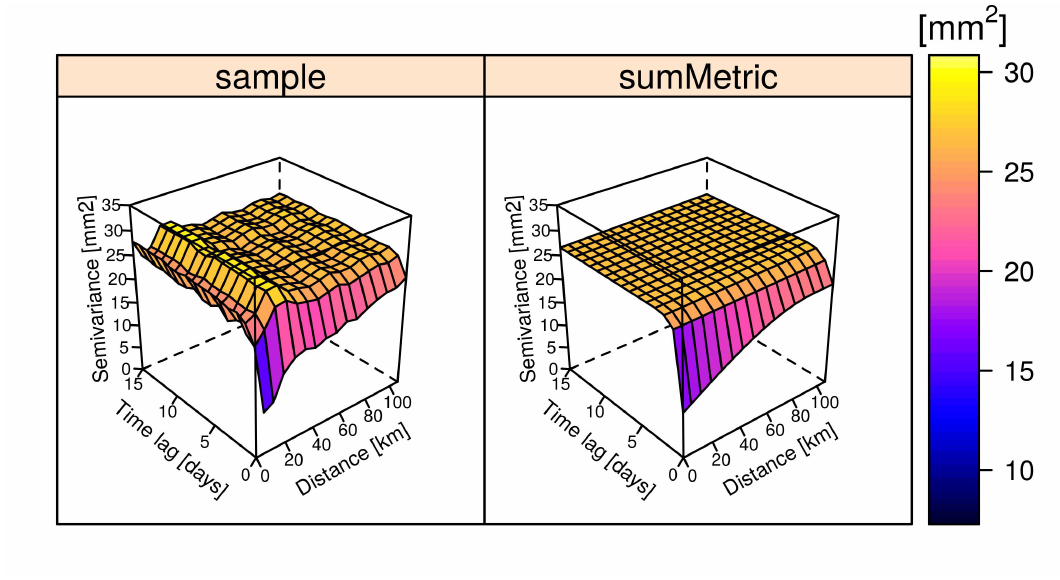
Figure 9. STRK sample semivariogram and fitted sum-metric semivariogram. Table 2. Sum-metric semivariogram parameters of the STRK model.